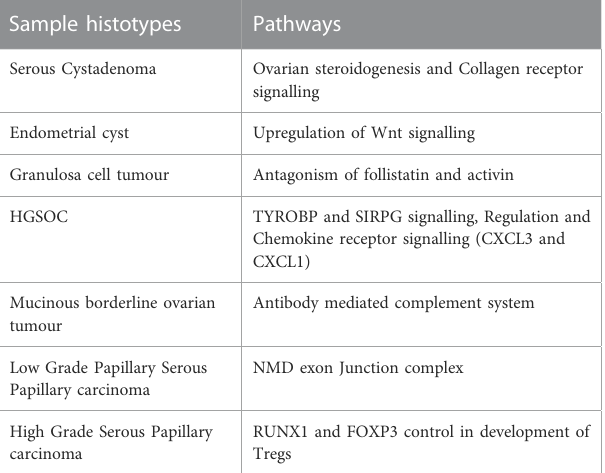
TABLE 5 WGCNA curated module pathways for the sample histotypes.